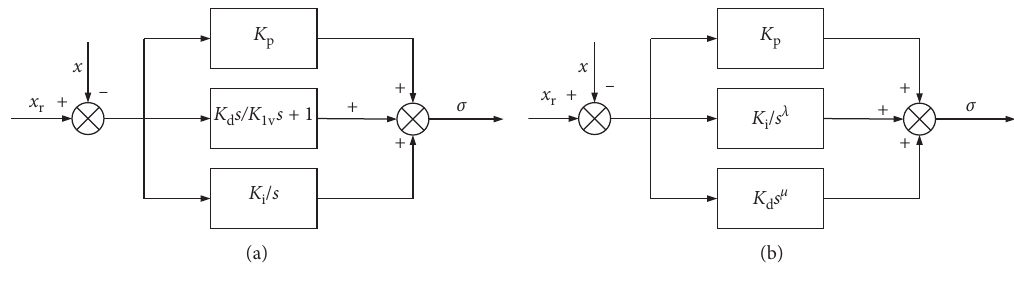
Figure 1: Controllers: (a) PID and (b) FOPID. Table 1: Transferring parameters in hydroturbine and generator under two working conditions.